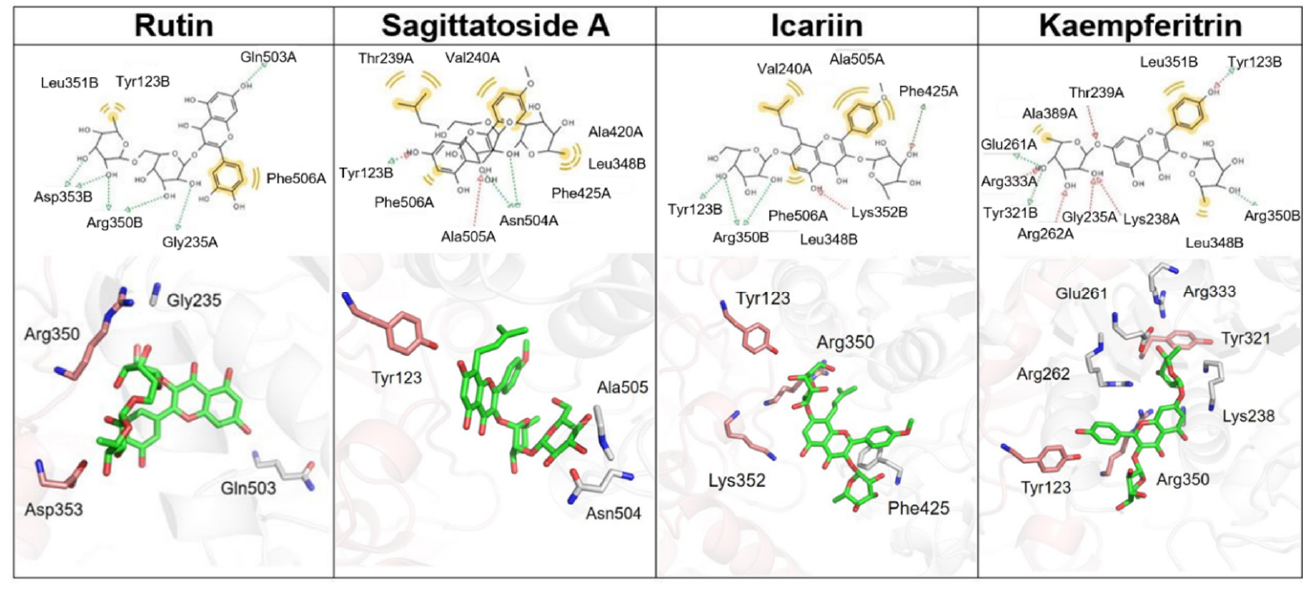
Figure 7. The 2D and 3D binding poses of candidates in a binding site of V-ATPase. Ligands (green) are bound with amino acids in chain A (white) and chain B (pink). The pharmacophore features are represented as green arrows (HBD), red arrows (HBA), and yellow spheres (hydrophobic property).